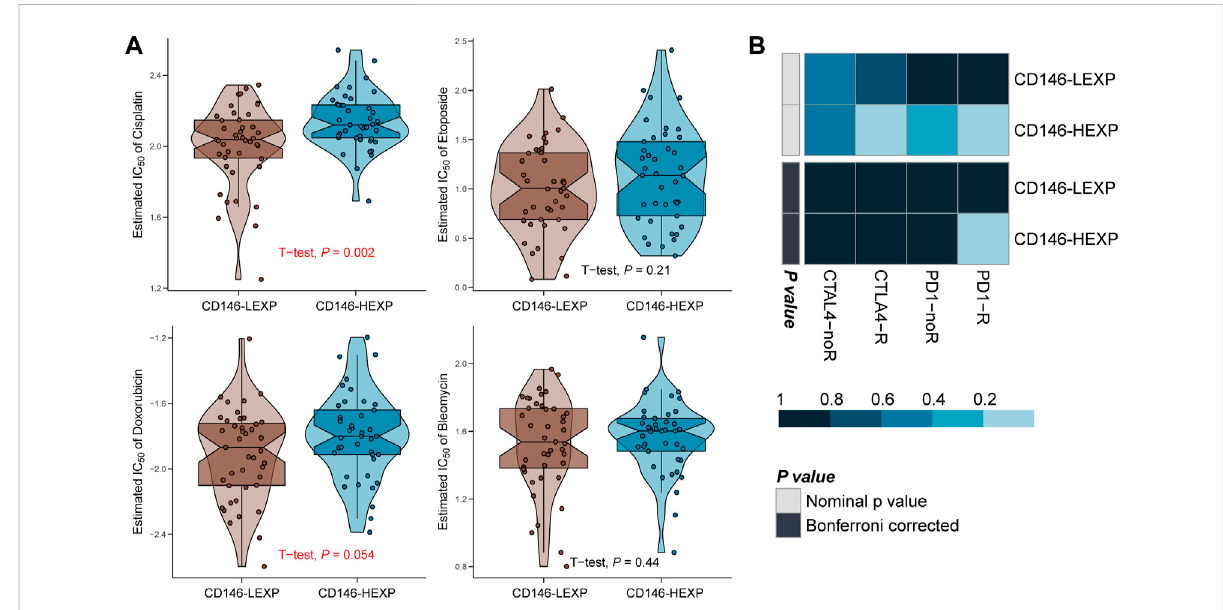
FIGURE 6 The CD146 level re fl ected the response to immunotherapy and chemotherapy. (A) The response of OSA patients to four common chemotherapy drugs, cisplatin, etoposide, doxorubicin, and bleomycin. (B) The response of OSA patients to anti-PD-1 and anti-CTAL4